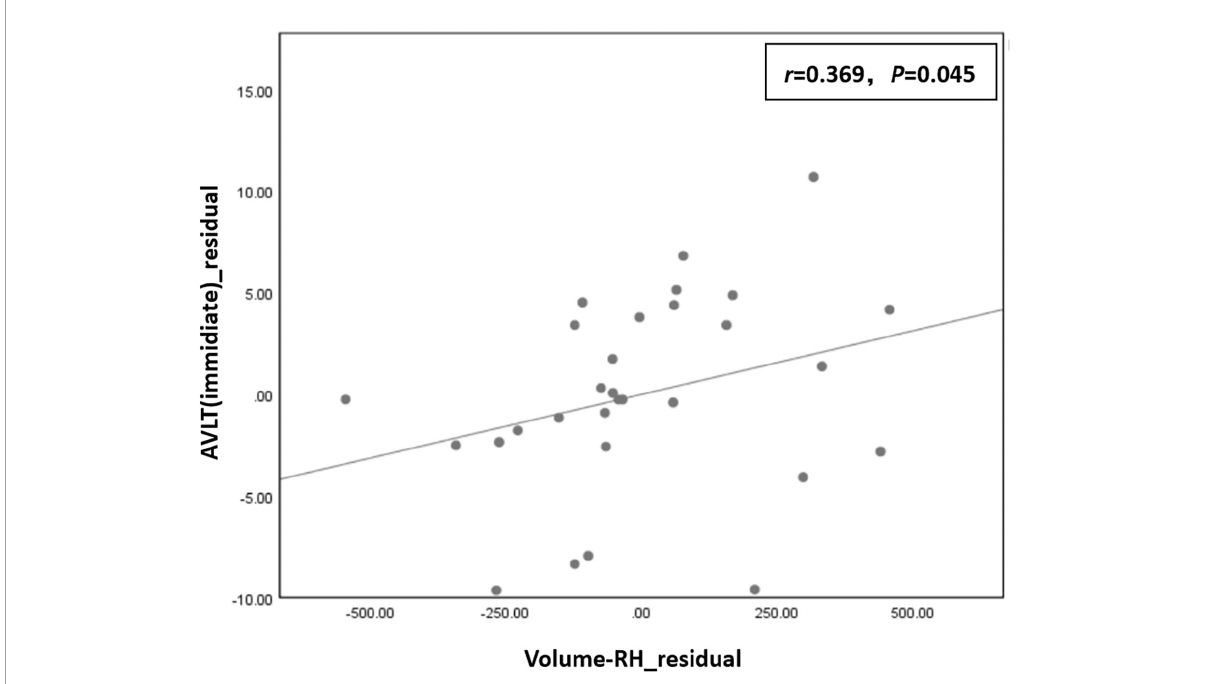
FIGURE4 The residual of the auditory-verbal learning test (AVLT) (immediate) score was positively correlated with the residual of right hippocampal volume ( r = 0.369, P = 0.045) in the type 2 diabetes mellitus (T2DM)